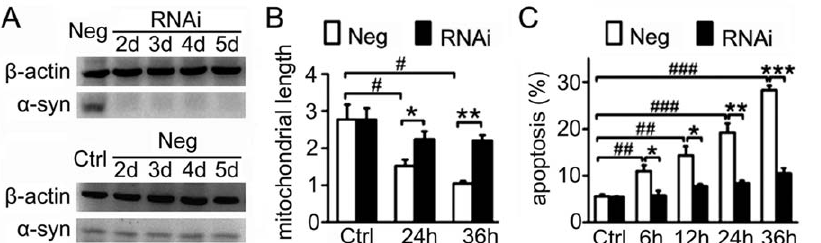
Figure 6. a -Synuclein knockdown prevents MPP + -induced cell apoptosis and mitochondrial fragmentation in SH-SY5Y cells. A. Immunoblotting assay demonstrates that a -synuclein expression is remarkably suppressed in SH-SY5Y cells transfected with SNCA siRNA (RNAi group) for 2–5 d, yet it is hardly affected in cells transfected with a negative control sequence (Neg group) (n=5). B. Quantitative analysis of changes in mitochondrial length shows that MPP + (1 mM) decreases mitochondrial length in Neg group, however, it has little effect on the index in RNAi group. Images of 20 cells from each group were processed for mitochondrial morphology analysis, and the experiment was repeated three times. C. Flow cytometric analysis of cell apoptosis shows that MPP + leads to severe cell injury in Neg group, while it slightly harms SH-SY5Y cells in RNAi group (n=4). *P , 0.05, **P , 0.01, ***P , 0.001 Neg versus RNAi; # P , 0.05, ## P , 0.01, ### P , 0.001 compared with Neg control.